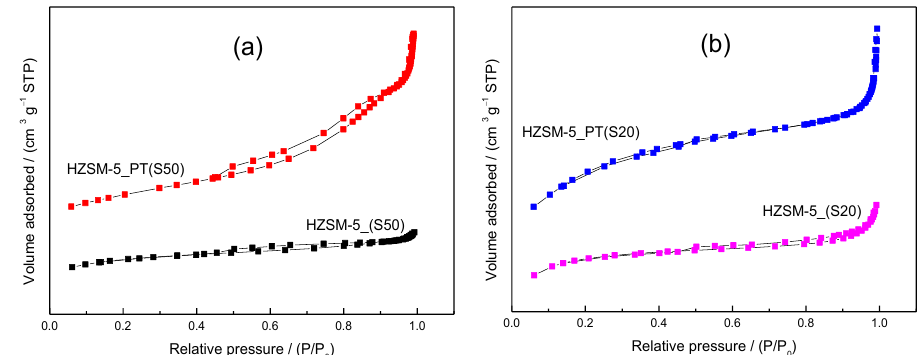
Figure 2. Nitrogen adsorption-desorption isotherms of parent and post-treated ( a ) SAR 50 zeolites and ( b ) SAR 20 zeolites.